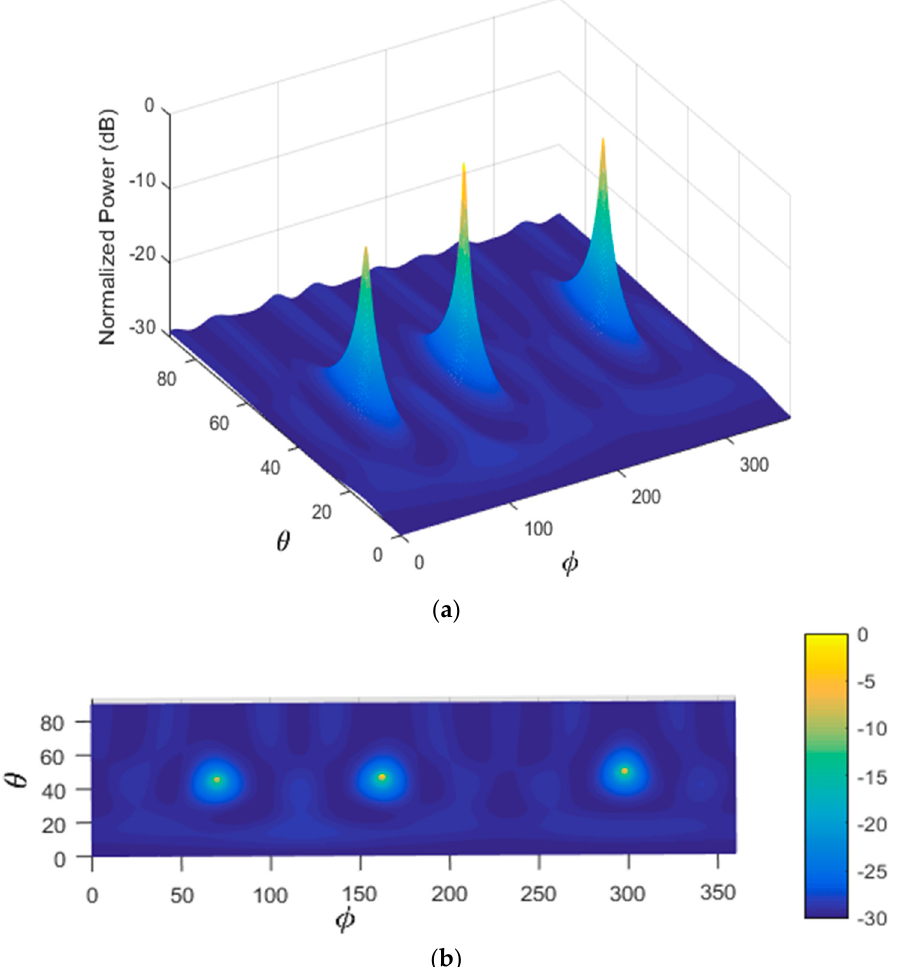
Figure 5. Performance estimation of the PDDA method with three AOAs. ( a ) 3D plot of the PDDA method; ( b ) 2D plot of the PDDA method.